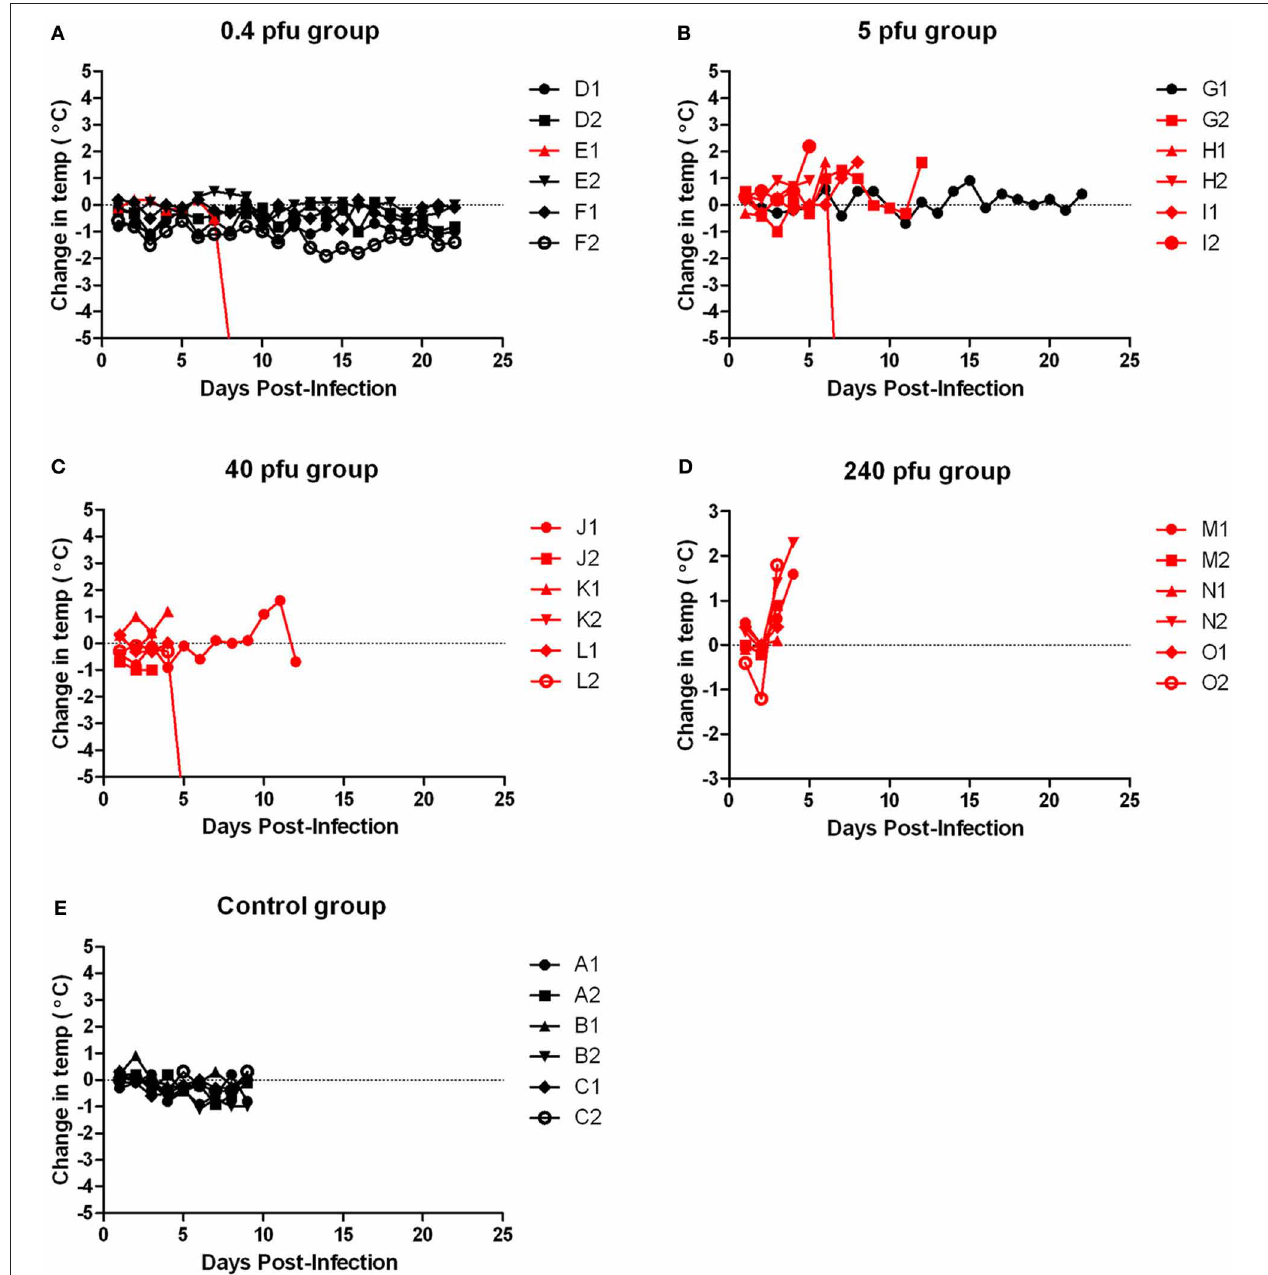
FIGURE 3 | Body temperature of Wistar-Furth rats infected with aerosolized RVFV. Groups of six female Wistar-Furth rats were infected with RVFV by the aerosol route at four doses plus uninfected controls. (A) 0.4pfu/rat; (B) 5pfu/rat; (C) 40pfu/rat; (D) 240 pfu/rat; (E) uninfected